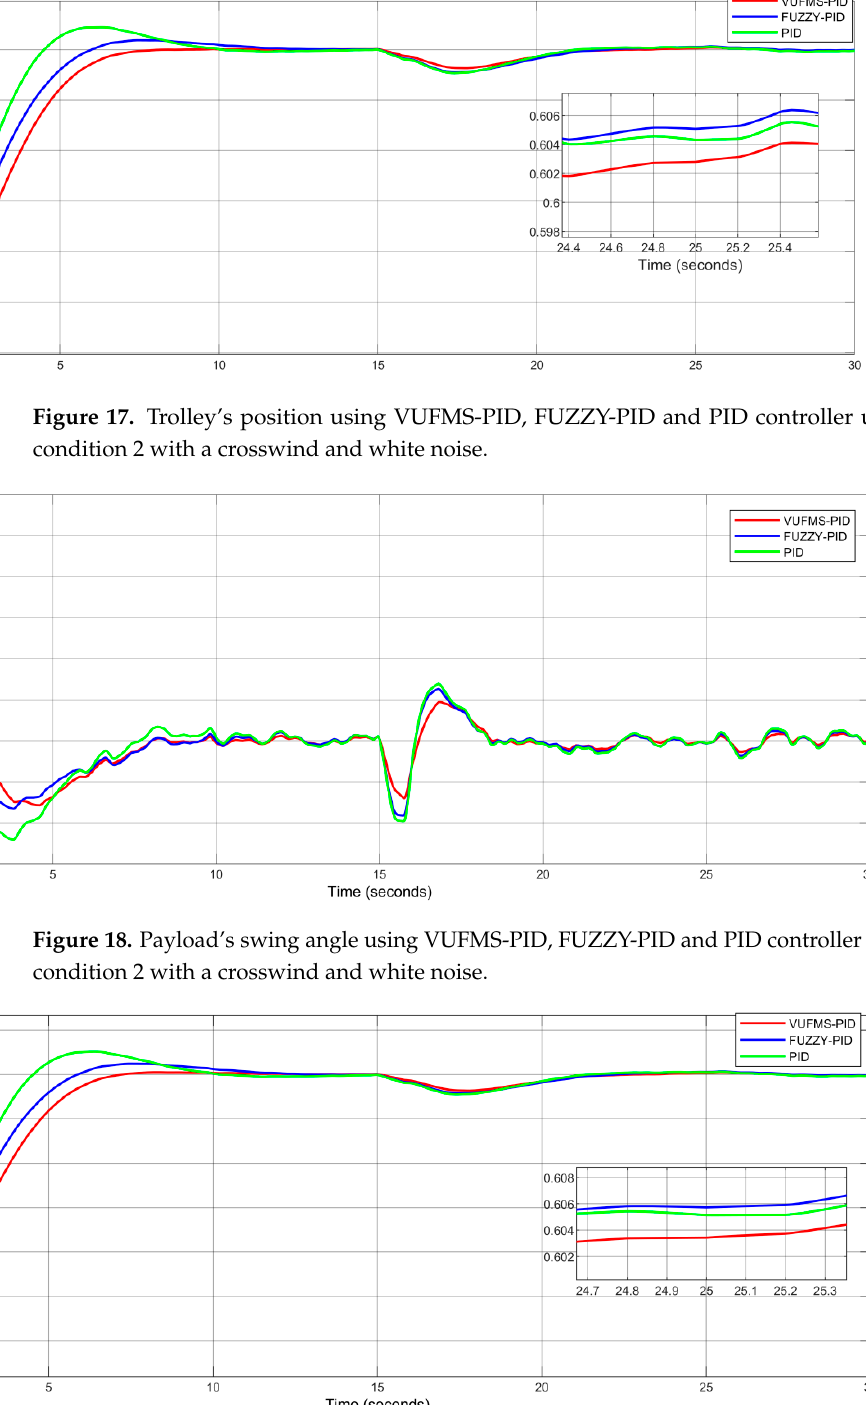
Figure 19. Trolley’s position using VUFMS-PID, FUZZY-PID and PID controller under working condition 3 with a crosswind and white noise.